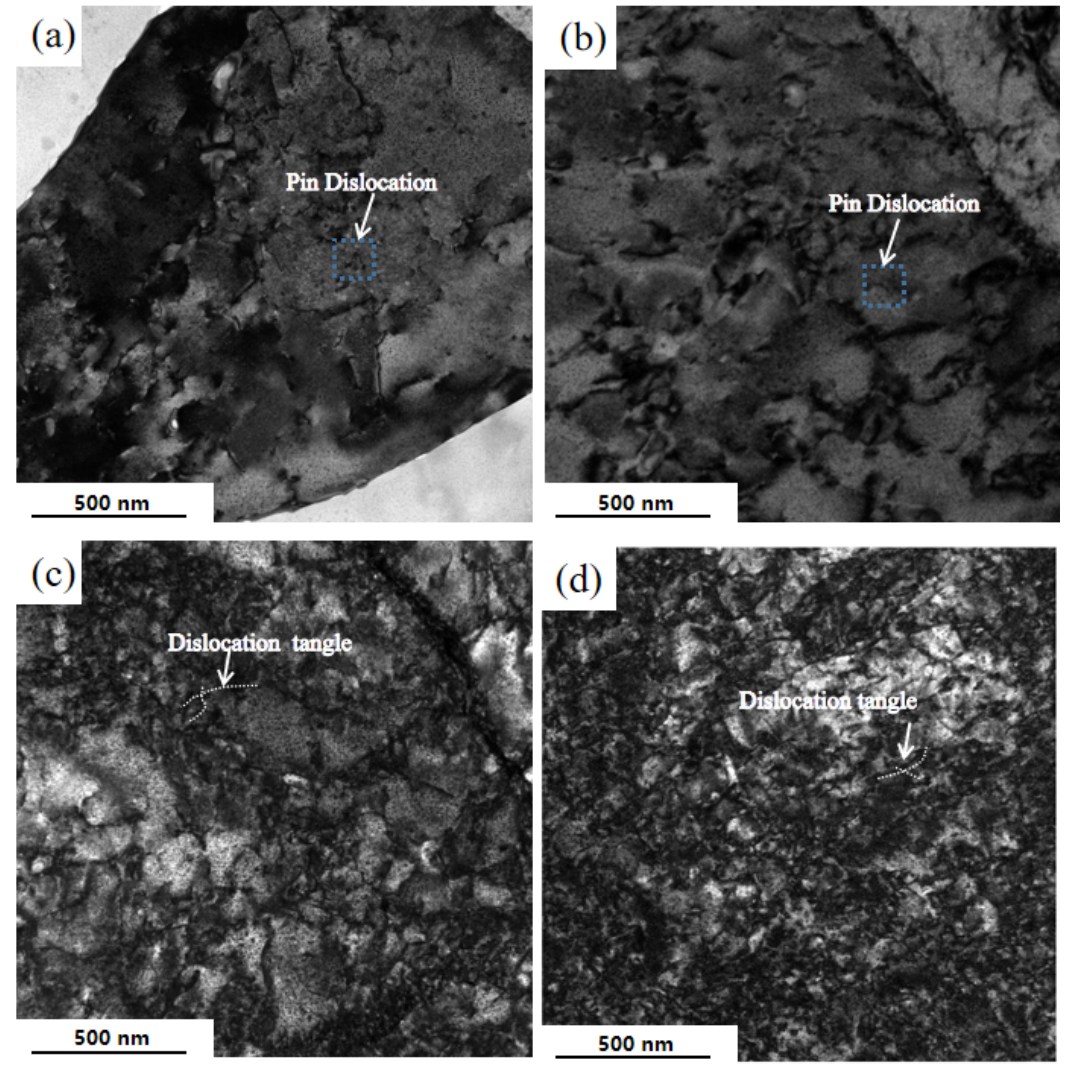
Figure 8. TEM images show the distribution of dislocations in creep-aged samples: ( a ) at 160 °C under 250 MPa for 1 h; ( b ) at 140 °C under 250 MPa for 8 h; ( c ) at 160 °C under 10 MPa for 8 h; ( d ) at under 250 MPa for 1 h; ( b ) at 140 ◦ C under 250 MPa for 8 h; ( c ) at 160 ◦ C under 10 MPa for 8 h; ( d ) at 160 °C under 250 MPa for 8 h. 160 ◦ C under 250 MPa for 8